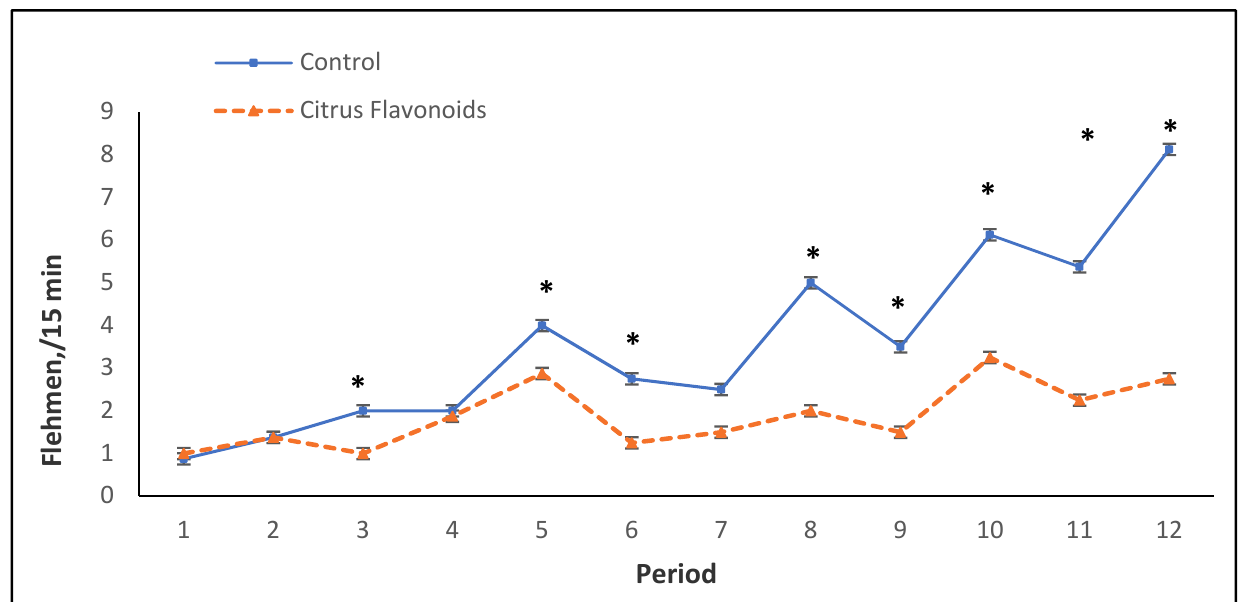
Figure 2. Flehmen every 15 min during the growing and finishing phase of Holstein bulls fed high-concentrate diets with or without citrus flavonoids supplementation (* = p < 0.05). Table 3. General activities (%) and social behavior (times/15 min) for growing phase in Holstein bulls fed high-concentrate diets supplemented with citrus flavonoids.